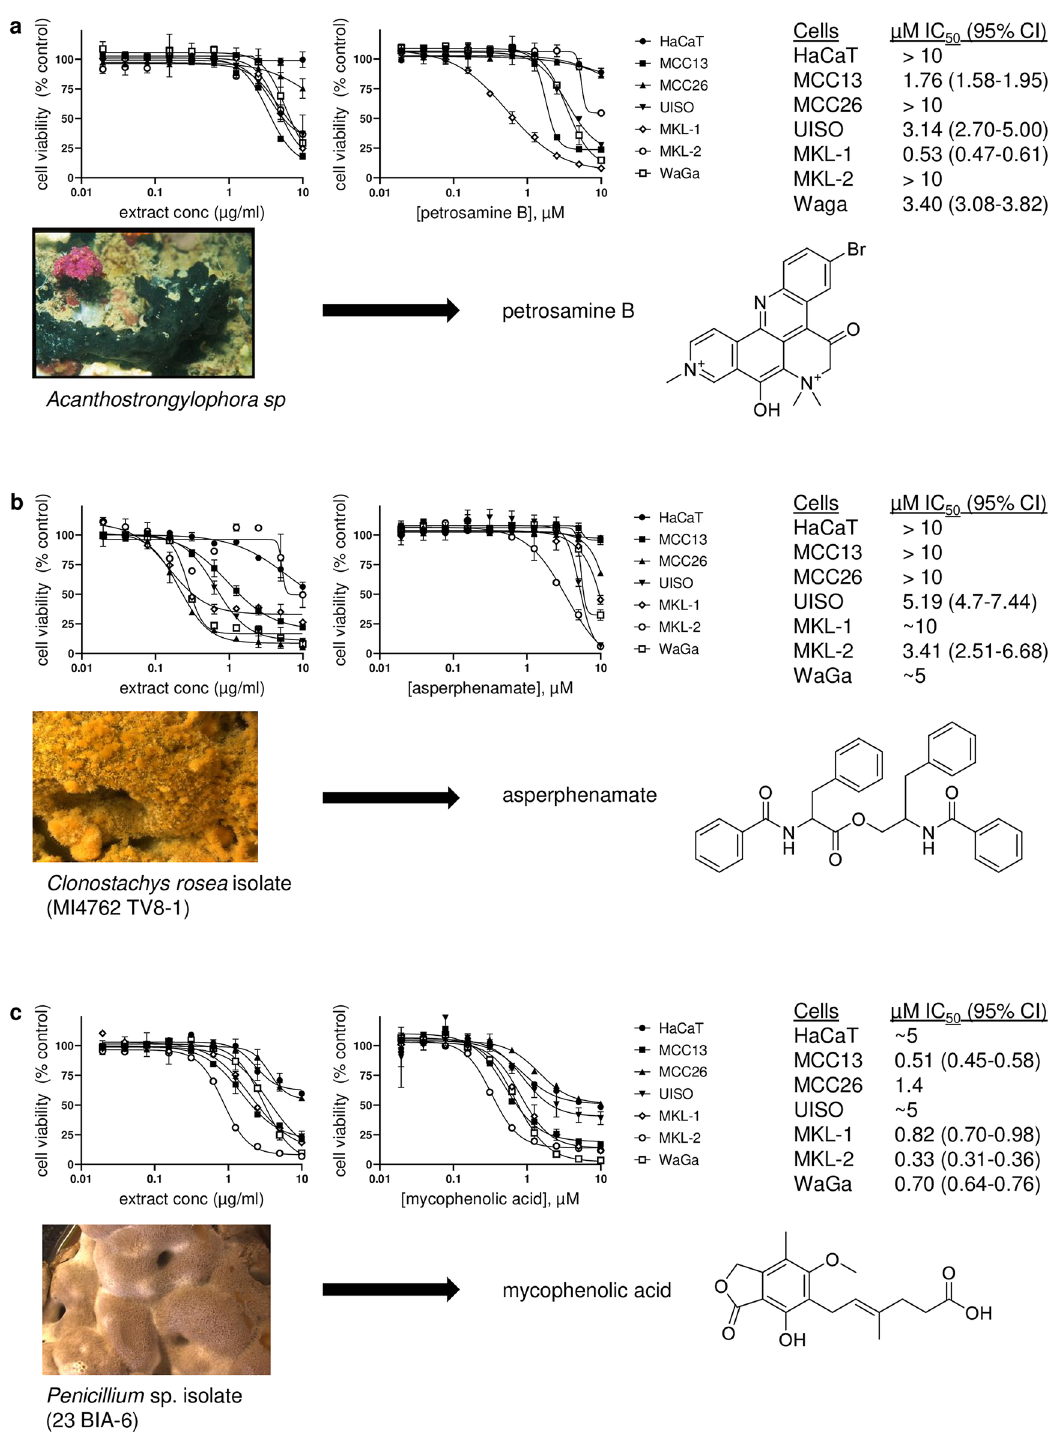
Figure 3. Natural product extracts and derived active compounds. Natural product extracts that reduced MCC cell viability were assessed for activity against the 7 cell lines discussed in the text (left graph in each panel). Pure compounds obtained from these extracts were similarly assessed for activity and IC 50 values calculated via GraphPad Prism software (right graph and table in each panel). Source organisms and compound isolation and structure elucidation are further discussed in Supplementary Information. Photograph of Acanthostrongylophora sp. taken by the Coral Reef Research Foundation under contract to (and provided by) the Natural Products Branch of the National Cancer Institute. Photos of the fungi ( Clonostachys rosea and Penicillium sp.) were obtained the University of Oklahoma. Compound structures were obtained from the PubChem